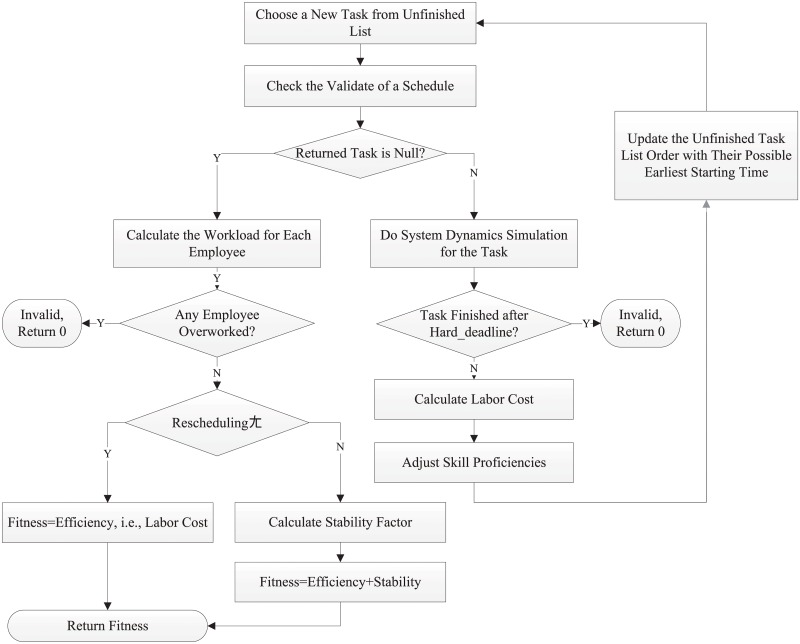
Fitness Function Calculation.